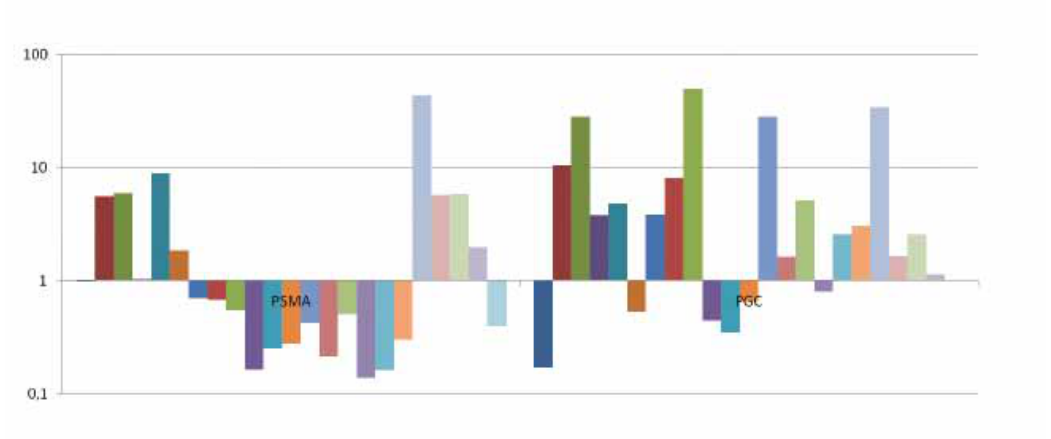
Figure 1. Quantitative expression of PsMA and PgC in tissue samples from patients with positive TRus guided prostate